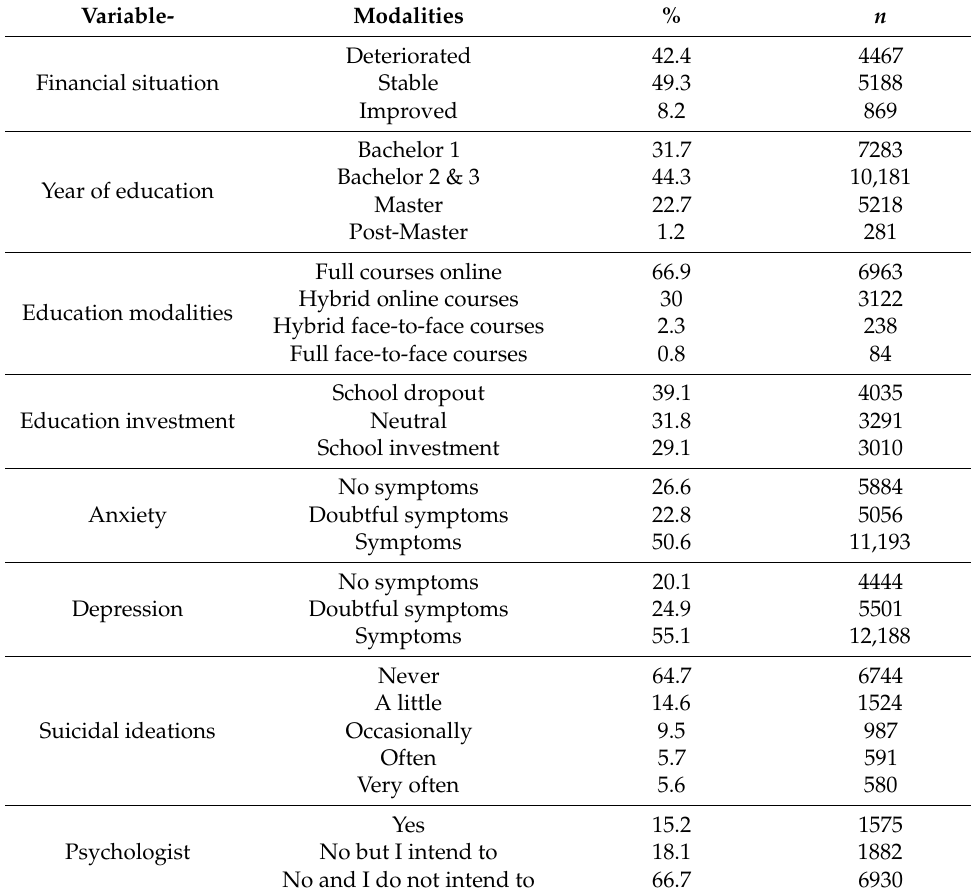
Table 1. Descriptive statistics.